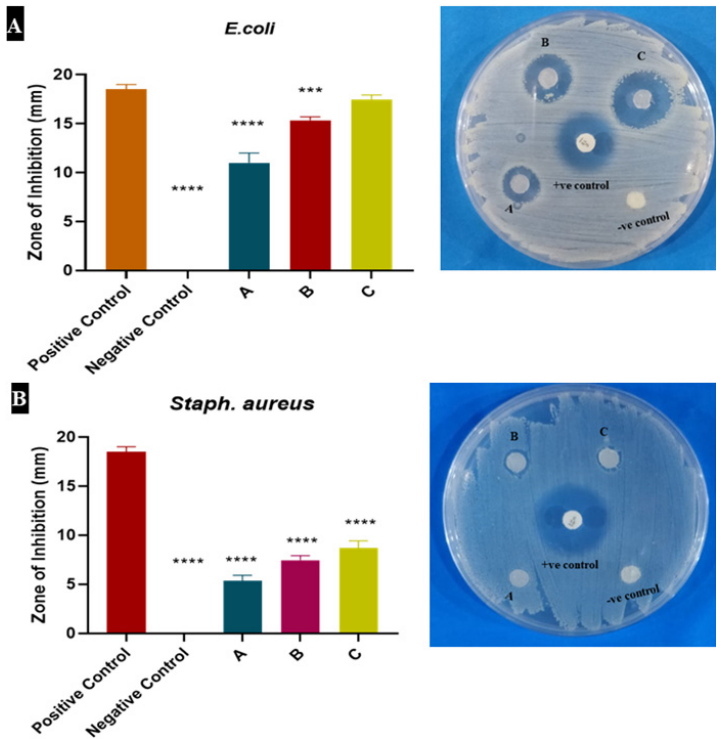
Figure 3. Antibacterial activity of alginate and heparin loaded alginate hydrogels by agar diffusion method: Zones of inhibition of hydrogels against E. coli ( A ) and Staph. aureus ( B ).